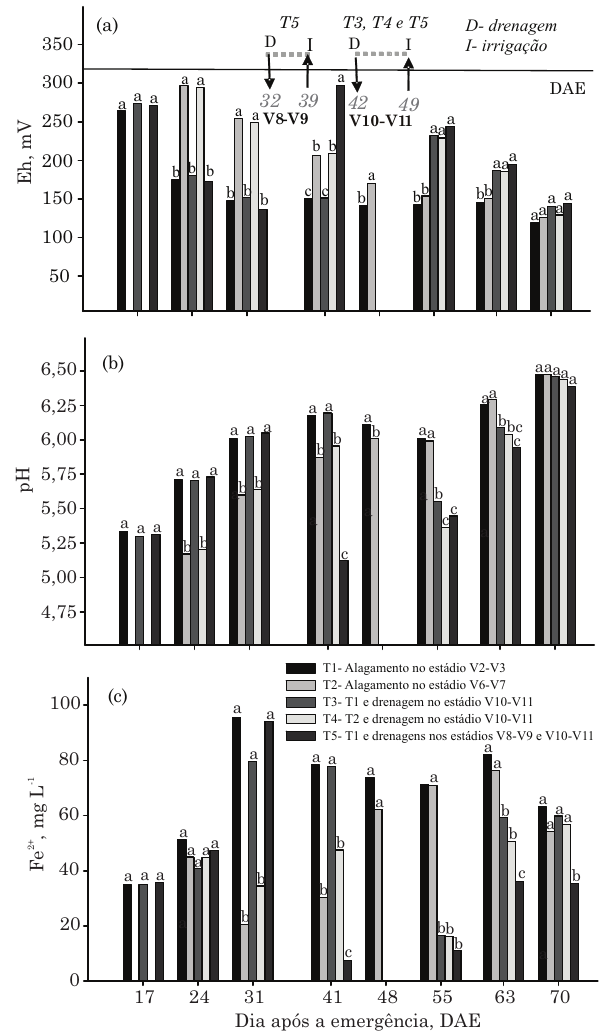
Figura 1. Eh (a), pH (b) e concentração de Fe 2+ (c) na solução do solo dos 17 até 70 DAE do arroz cultivado com manejos diferenciados da água. Letras minúsculas diferem entre si pelo teste de Duncan a 5 %, dentro de cada época de amostragem